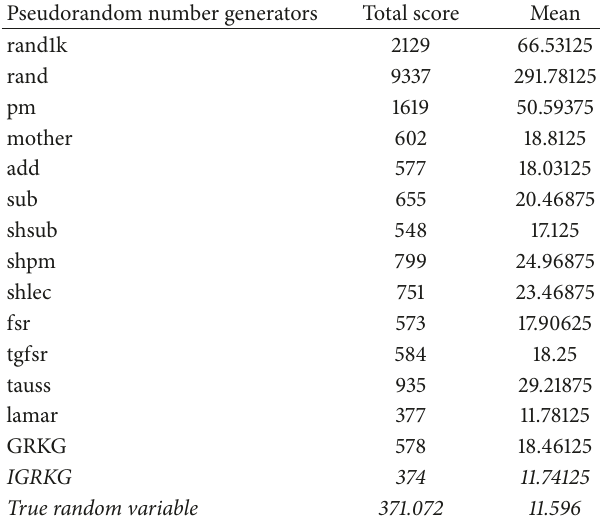
Table 14: Pseudorandom number generators Diehard scores. Pseudorandom number